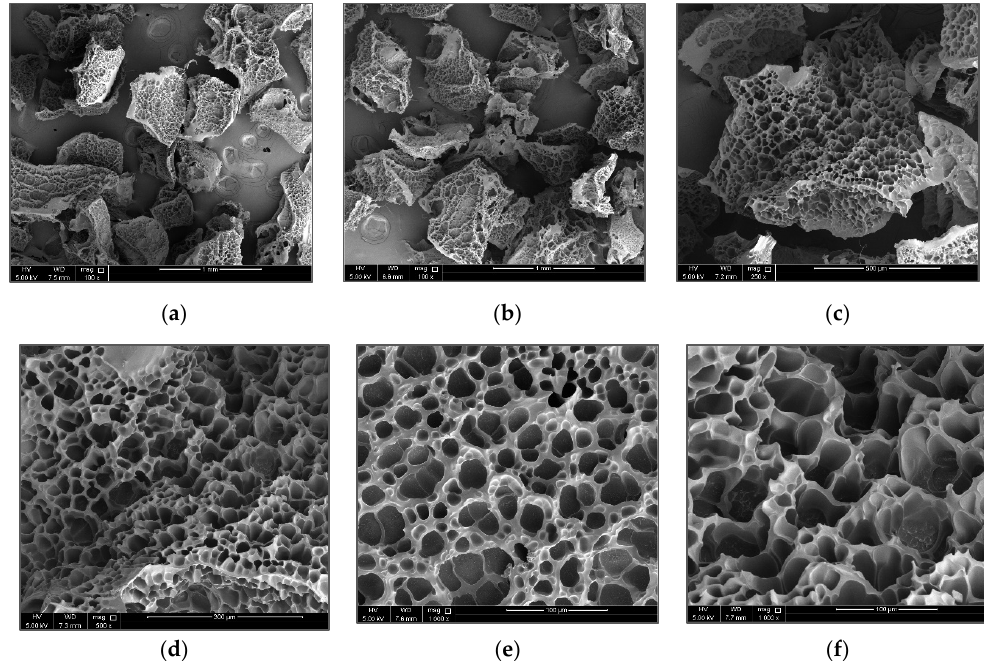
Figure 5. SEM images of swelled PAM/Cs PPG morphology with different magnifications ( a , b ) 100 × ; ( c ) 250 × ; ( d ) 500 × ; and ( e , f ) 1000 ×.